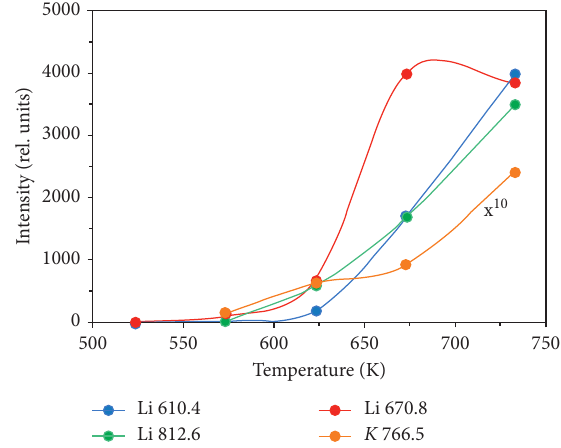
Figure 5: Dependence of intensity of lithium and potassium lines in the Kr-Xe mixture on the temperature of the lithium layer, F � 10 14 n/cm 2 s. The intensity of potassium lines increased by 10